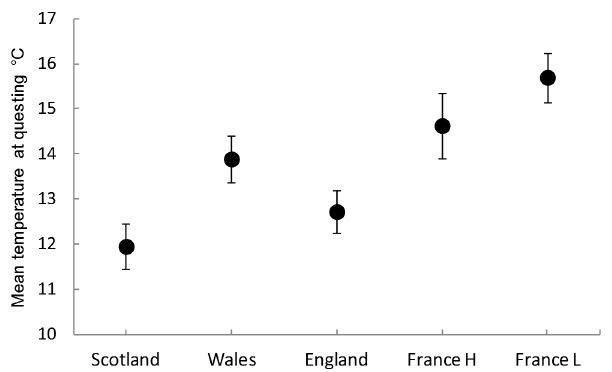
Figure 2. Mean ± 95% CI temperature at which questing was initiated in each tick population during the hourly tempera- ture increase experiments. H and L= High and Low altitude.